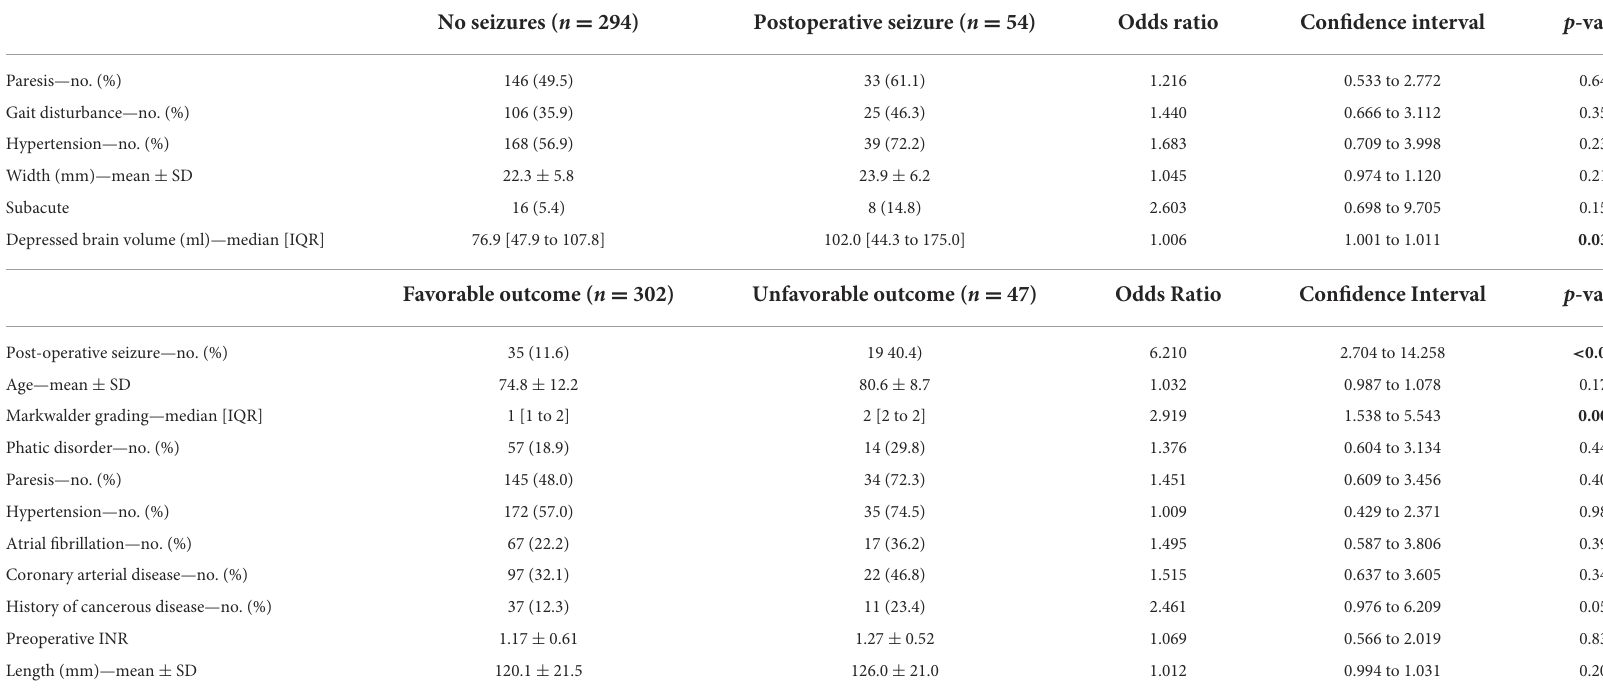
TABLE 3 Results of the logistic regression analysis of factors effecting postoperative seizure and dichotomized outcome. No seizures ( n = 294) Postoperative seizure ( n = 54) Odds ratio Confidence interval p -value